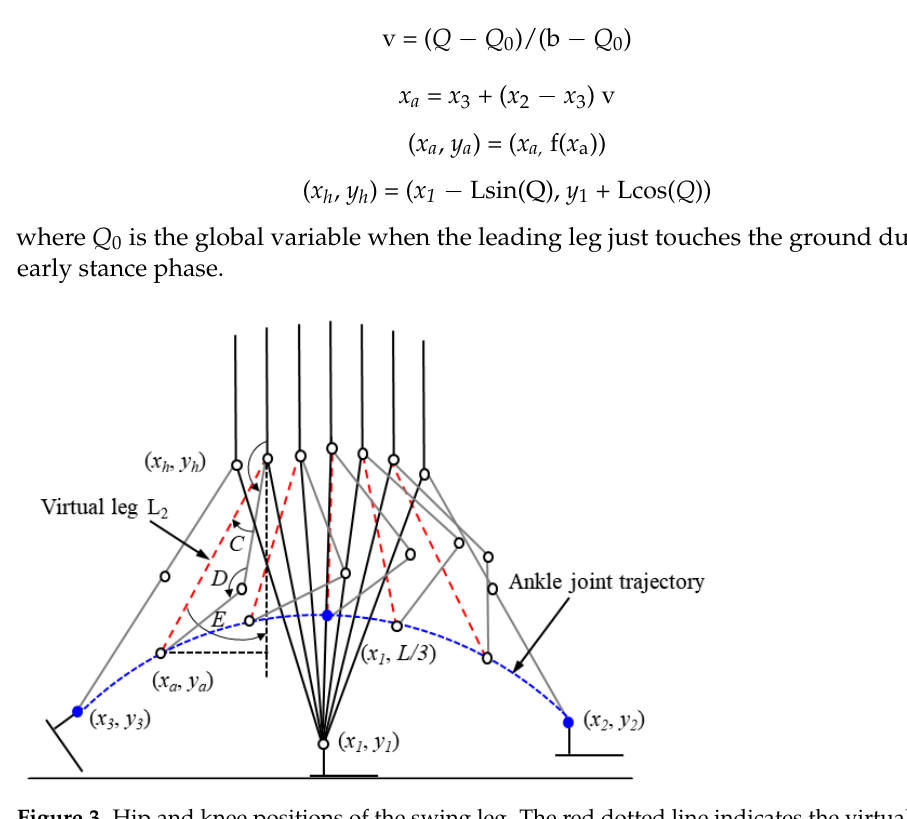
Figure 3. Hip and knee positions of the swing leg. The red dotted line indicates the virtual leg. The blue dotted line indicates the ankle joint trajectory of the swing leg.